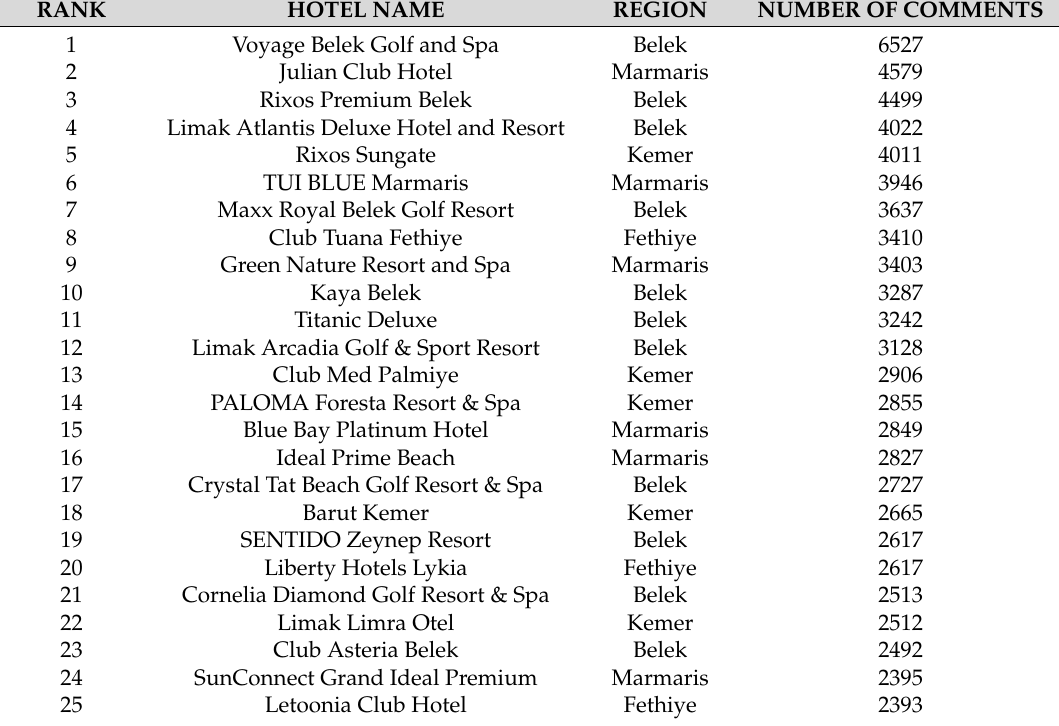
Table A1. The Mediterranean Region’s Hotels and